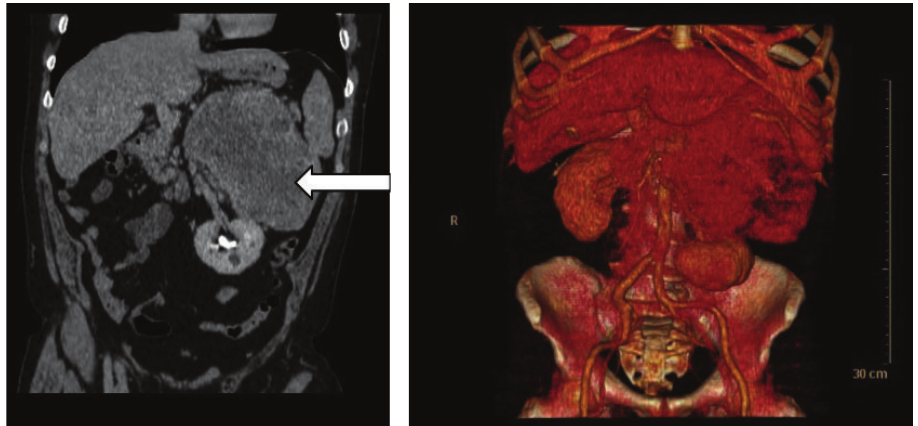
Figure 2: Adrenal CT Image shows a tumor on the left adrenal gland of 202 × 127 × 202 mm (white arrow) that displaces ipsilateral kidney and renal